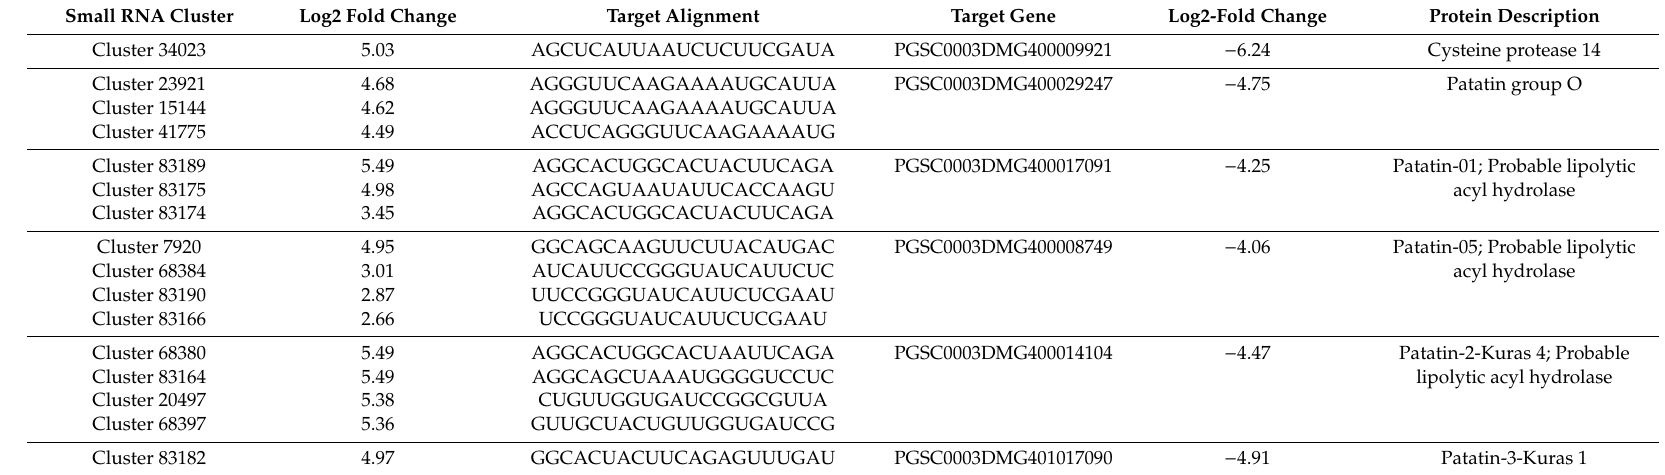
Table 3. List of di ff erentially expressed small RNA clusters in drought-stressed potato tubers that negatively correlate to target transcript expression. Target alignments, gene ID, expression and descriptions are